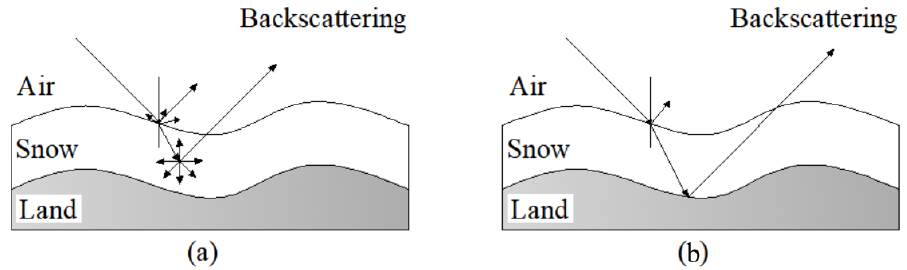
Figure 4. Microwave scattering mechanism: ( a ) wet snow; ( b ) dry snow.